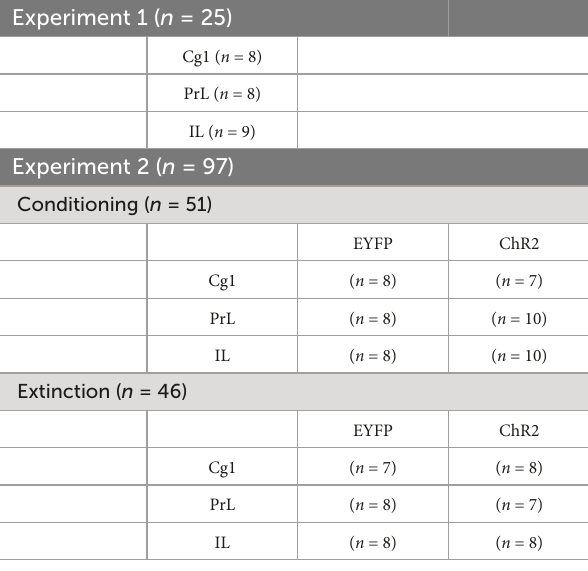
TABLE 1 Numbers of rats for each group in Experiments 1 and